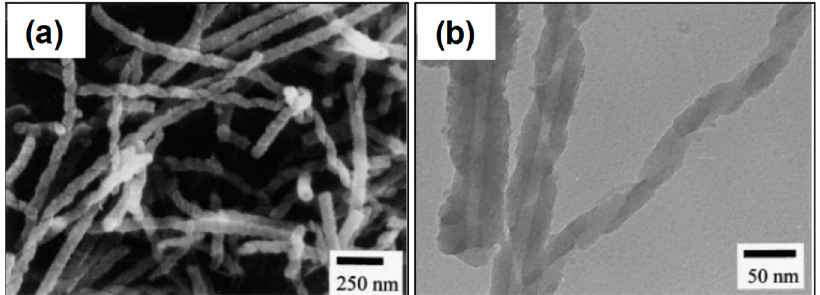
Figure 4. ( a ) SEM and ( b ) TEM images of silica structures prepared using the mixture of 21 and 22 as